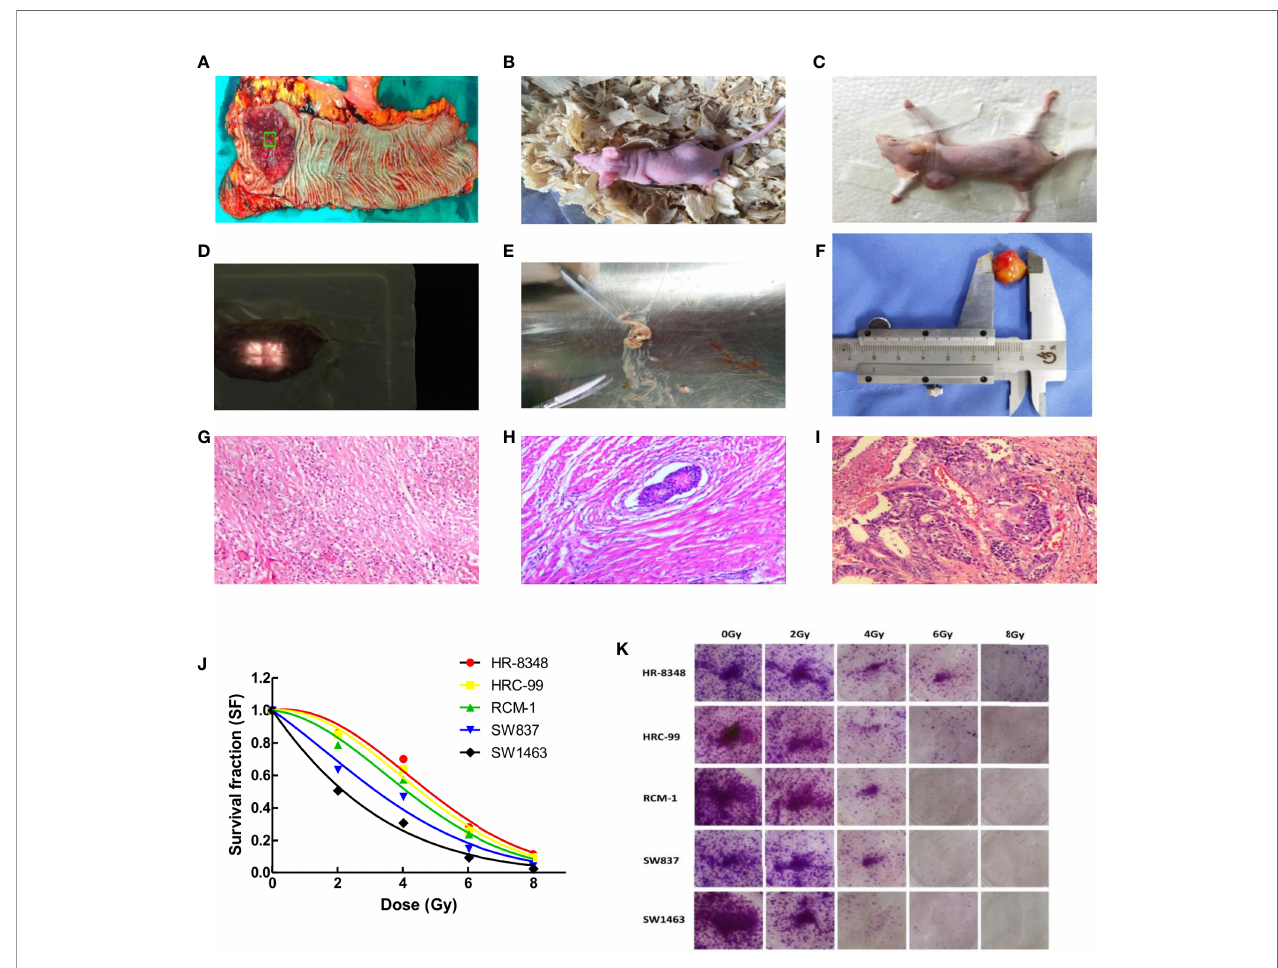
FIGURE 1 | Differential screening of irradiation reactivity to rectal cancer tissues and to rectal cancer cell lines. (A) Fresh specimen cut from the center of tumor; (B) Rectal cancer tissue was transplanted into nude mice to construct the fi rst generation PDX model; (C) Second generation PDX model for screening irradiation reactivity; (D) Compensation tissue and irradiation fi eld on the surface of xenograft tumor; (E) Irradiation caused liquefaction and necrosis of the tumor; (F) Measurement of xenograft tumor in vitro ; (G) Sterilization with marked fi brosis (RCRG1); (H) Marked fi brosis but macroscopic disease present (RCRG2); (I) Little or no fi brosis, with abundant macroscopic disease (RCRG3); (J) Status of fi ve rectal cancer cell lines exposed to irradiation, and survival fraction fi tted to the linear quadratic equation; (K) Colony formation assays of fi ve rectal cancer cell lines under irradiation